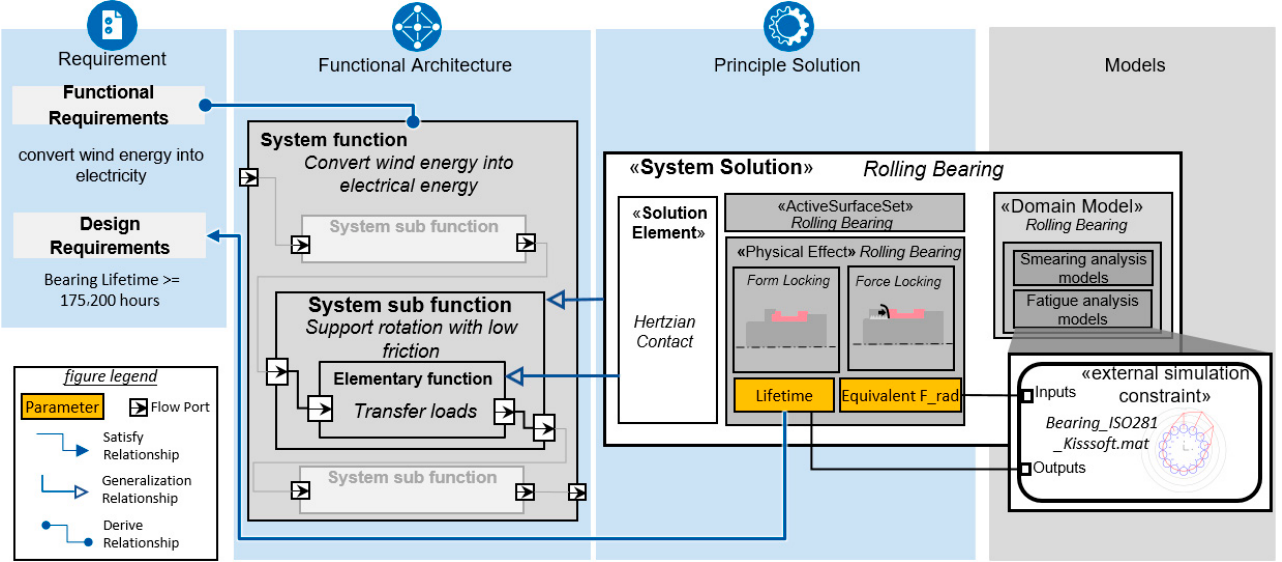
Figure 3. The schematic of function, solution, and domain model architecture in a system model .